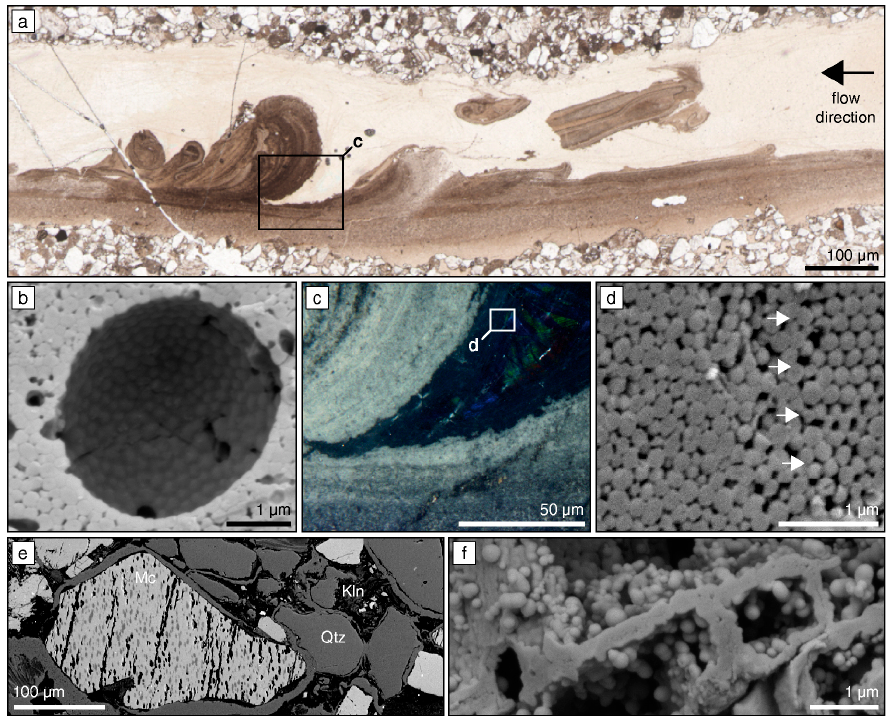
Figure 5. Textures and microstructural features of Mintabie vein opal ( a – d ) and its bleached sandstone host rock ( e – f ). ( a ) Microphotograph of a partially fragmented, brown opal (white in hand specimen) with roll-up structures overlain by transparent common and precious opal. The arrow indicates the flow direction of the concentrated colloid solution that deformed the brown opal. ( b ) SE image of sphere-lined pore space in the brown opal, typical of white opal at Mintabie and Andamooka. The sample was HF-etched prior to imaging. ( c ) Microphotograph of the area highlighted in ( a ), showing a wedge-shaped photonic crystal embedded in transparent common opal, between crossed polarizers. ( d ) SE image on HF-etched material of the area highlighted in c , showing the contact between transparent common and precious opal. Arrows emphasize the interface between disordered (left) and ordered (right) regions of similar-sized spheres. ( e ) Backscattered electron image of bleached Mintabie sandstone with microcline (Mc), quartz (Qtz), and kaolinite (Kln) in their typical spatial context. Microcline and quartz grains are surrounded by an opal-A cement. Na-rich regions (dark) in microcline dissolve preferentially during alteration. ( f ) SE image of an opal-A pseudomorph after microcline with dissolution cavities containing non-uniform spheres <300 nm in diameter. The opal-replaced cavity walls trace microcline cleavage